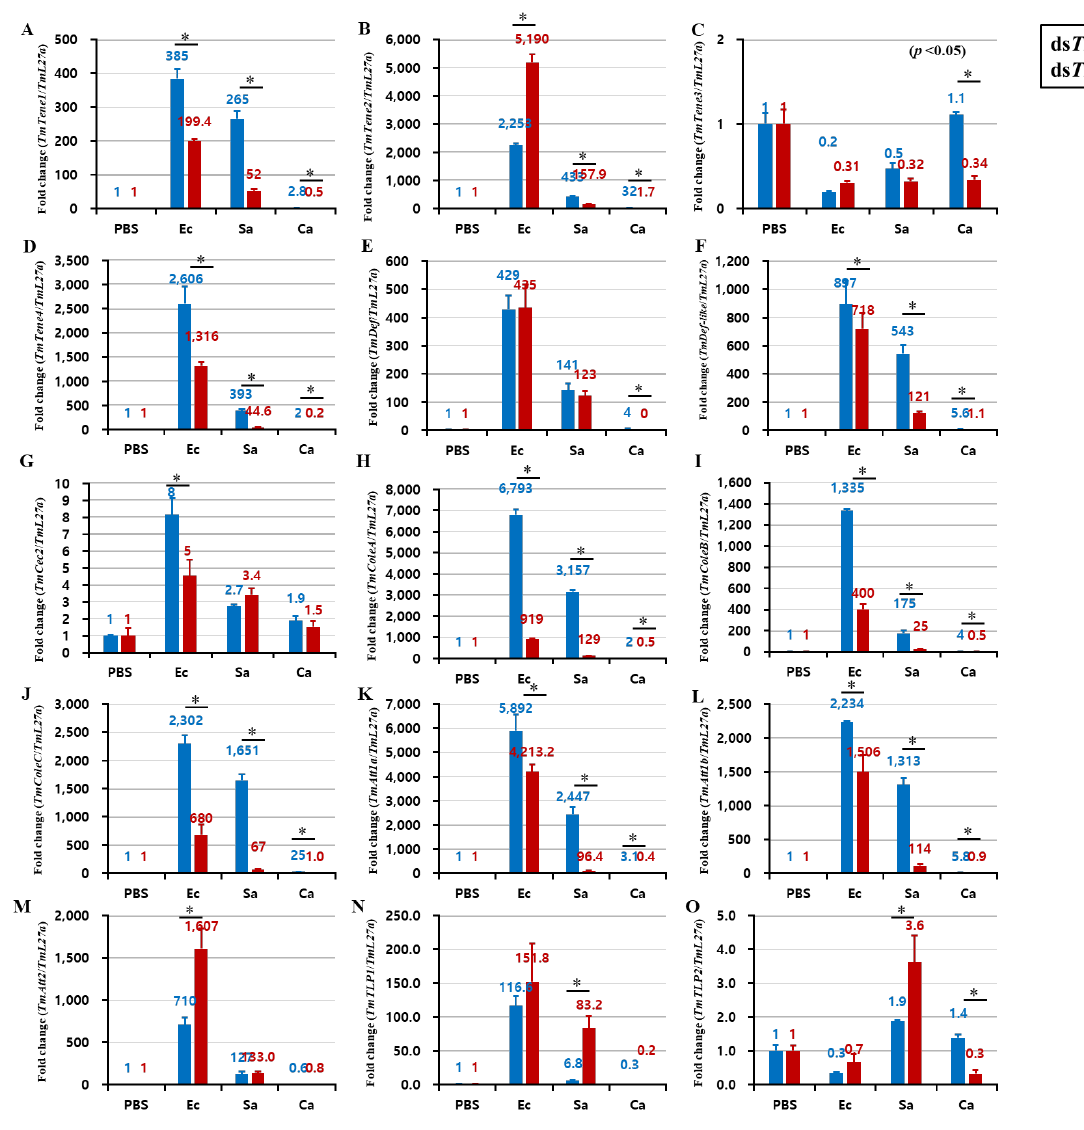
Figure 7. Effect of TmToll-2 gene silencing on the induction of 15 AMP genes in the Malpighian tubules of T. molitor larvae infected with E. coli (Ec), S. aureus (Sa), and C. albicans (Ca) by using PBS as the control. At 24 h post microbial injection, AMP genes, including TmTene1 ( A ), TmTene2 ( B ), TmTene3 ( C ), TmTene4 ( D ), TmDef ( E ), TmDef-like ( F ), TmCec2 ( G ), TmColeA ( H ), TmColeB ( I ), TmColeC ( J ), TmAtt1a ( K ), TmAtt1b ( L ), TmAtt2 ( M ), TmTLP1 ( N ), and TmTLP2 ( O ) were examined via qPCR by using ds TmVer as a knockdown control and T. molitor ribosomal protein ( TmL27a ) as an internal control. All experiments were performed in triplicate. Asterisks indicate significant differences between ds TmToll-2 - and ds TmVer RNAi-treated groups determined by Student’s t -test ( p < 0.05).